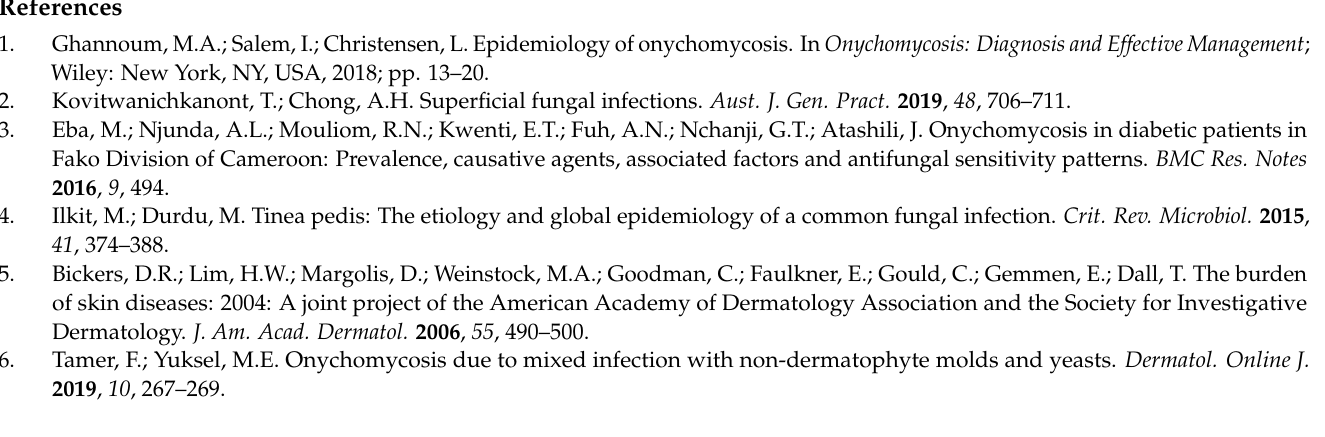
Figure S5: Clinical appearance of toenails grouped by MLIA. Trichophyton mentagrophytes (top), T. rubrum (middle) and an NDM (bottom) as the dominant fungus. Mycotic nails are 1–10 and 12–19; control nails are 11 and 20 (not pictured); Figure S6: Sample read counts (A) and sequence quality (B) from 16S primers. The top five results for the bacteria comprised well over 80% of the total population/ community detected in most nails. Staphylococcus epidermidis DNA was found in every nail including the two controls. Rothia koreensis was also prominent as was Brevibacterium sediminis (Table S5); Figure S7: Score plot from PCA, showing the separation of three clusters of nails characterised by the subdominant bacteria; Table S1: Primers used for sequencing by locus; Table S2: ITS2 rRNA Results; Table S3: 16S rRNA results; Table S4: Predominant organism percentage of hits, with most likely infecting agent (MLIA); Table S5: Nails with both T. rubrum and T. mentagrophytes present and showing the dominance of one dermatophyte over the other; Table S6: Correlations between results of sequencing the 16S region in DNA from